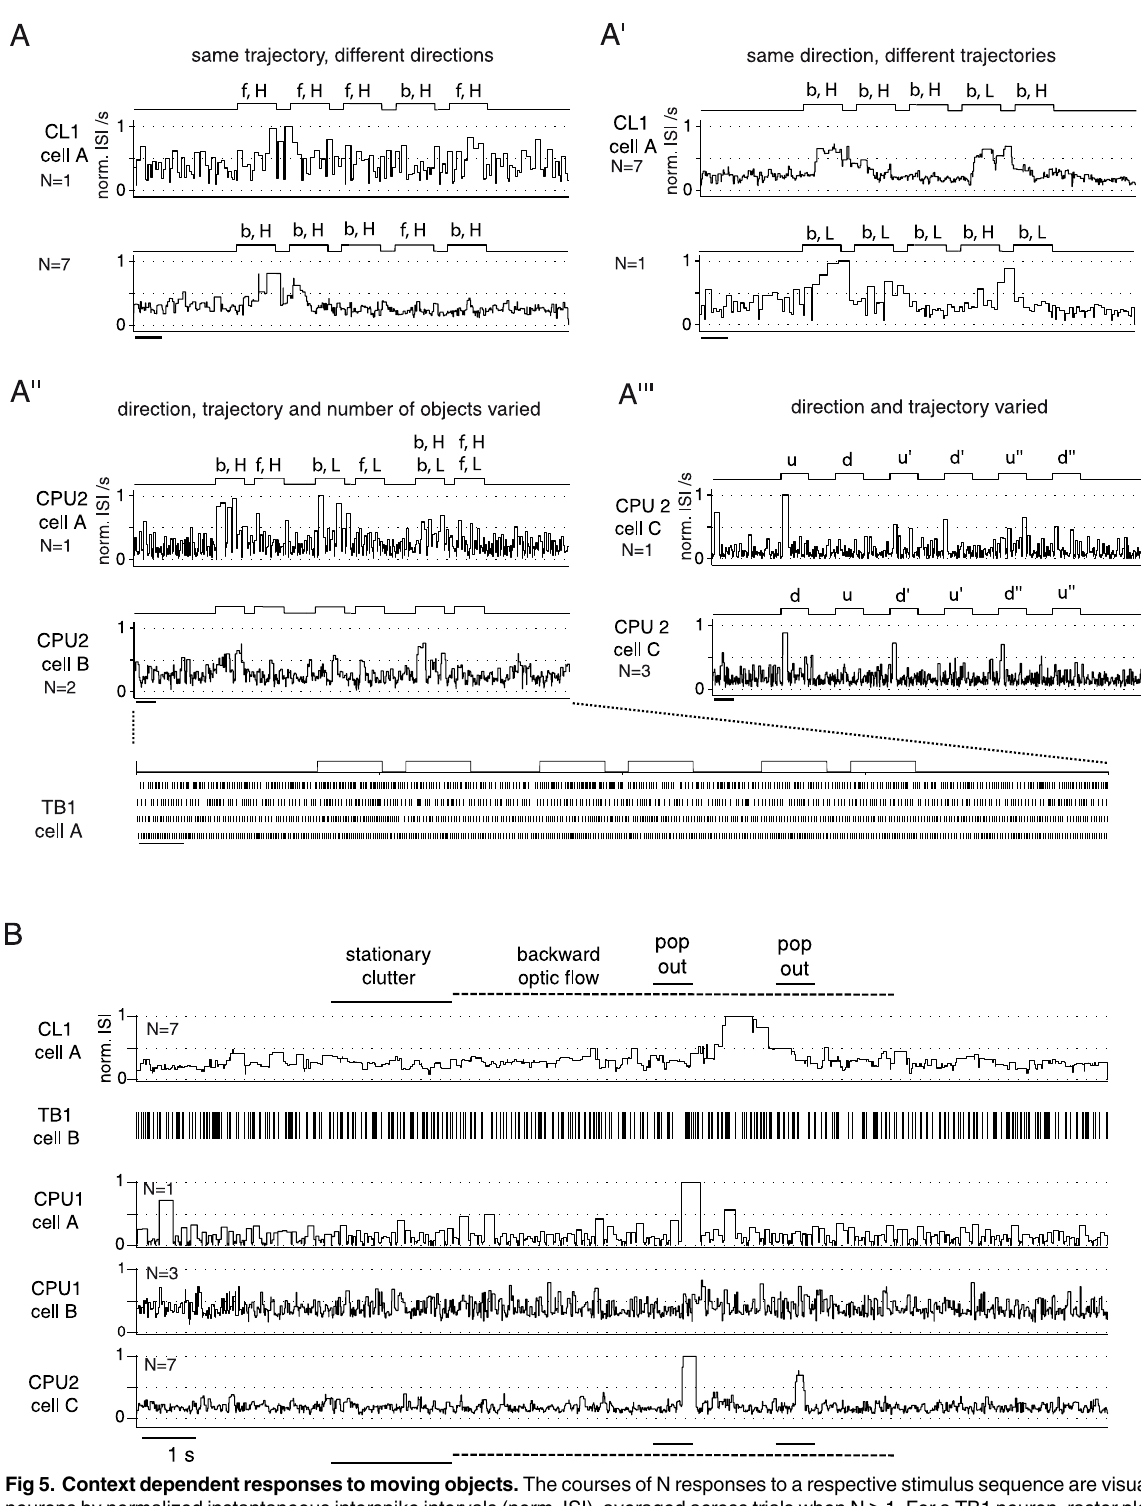
Fig 5. Context dependent responses to moving objects. The courses of N responses to a respective stimulus sequence are visualized for selected neurons by normalized instantaneous interspike intervals (norm. ISI), averaged across trials when N > 1. For a TB1 neuron, raster plots were preferred. Values of 0 or 1 indicate highest consistency in response course across trials. A-A'''. Each subplot represents N responses to a specific stimulus sequence, obtained from cells identified by capital letters within each cell type (compare to subfigure B). A-A'': Horizontal trajectories; forward (f) or backward (b) motion at high (H) or low (L) elevation. In A'', the third and fourth stimulus consist of two objects that move in the same direction but at different elevations.